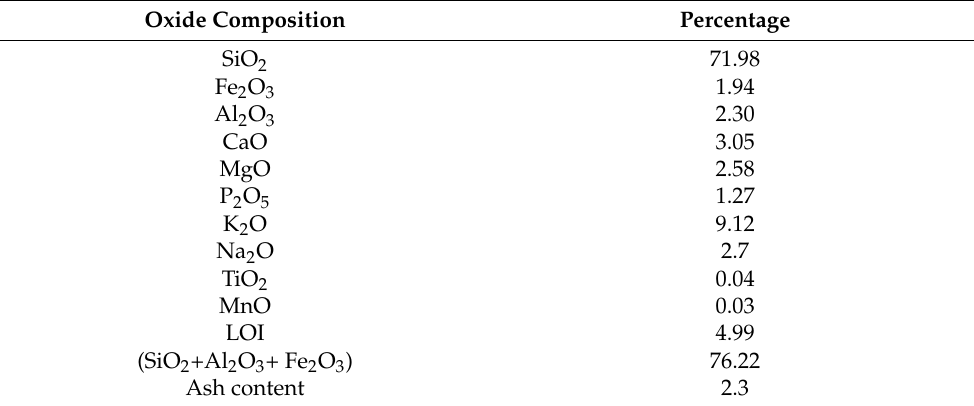
Table 2. Chemical composition of